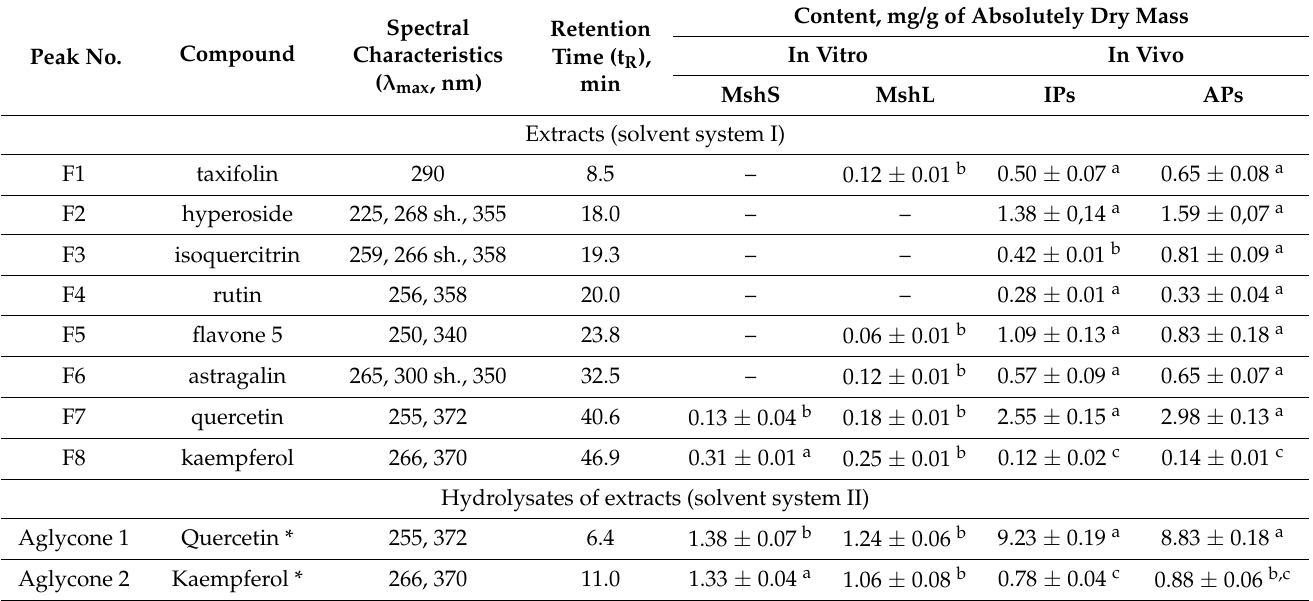
Table 3. Characteristics and levels of the flavonoids detected by HPLC in S. betulifolia ssp. aemiliana